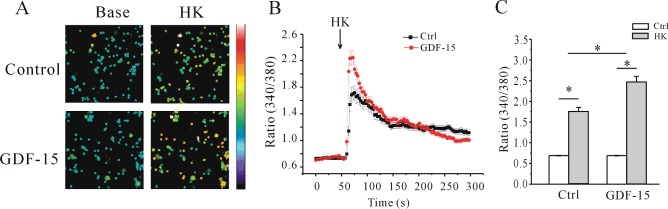
Effect of GDF-15 on [Ca2+]i induced by high K+ in rat CGNs(A) Intracellular Ca2+ imaging of control and GDF-15-treated CGNs before (Base) and after (HK) depolarization by acute perfusion with 27 mM K+. Changes in fura 2 fluorescence excitation ratios with increasing [Ca2+]i are depicted as a colour gradient from purple to red. Scale bar, 50 μm. (B) Changes in [Ca2+]i upon application of a depolarizing stimulus, as measured by quantification of fluorescence excitation ratios. The arrow represents a 30-s perfusion with a depolarizing solution of 27 mM K+. (C) Statistical analysis of [Ca2+]i induced by high K+ in the presence or absence of GDF-15. Results are means±S.E.M. *P<0.05 for the two groups connected with a straight line. Ctrl, control.